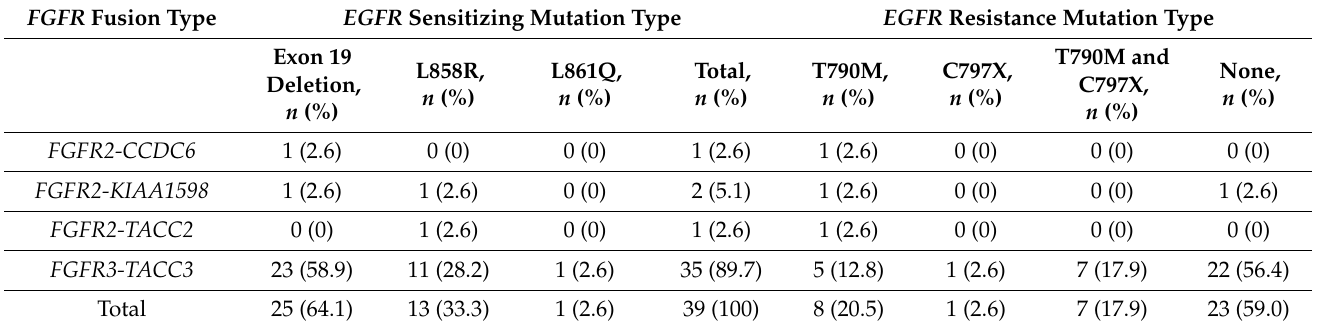
Table 2. EGFR mutation types co-occurring with FGFR2/3 fusions in the Guardant Health electronic